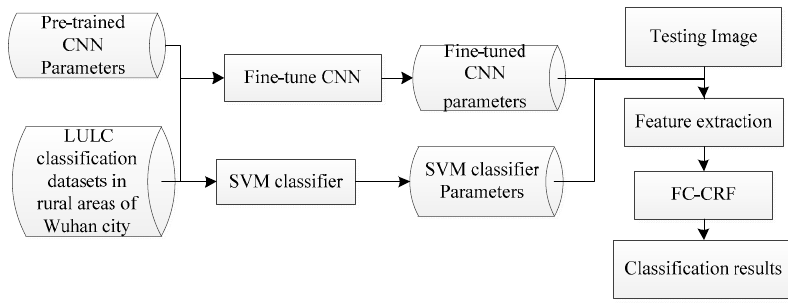
Figure 3. The flow chart of proposed method.